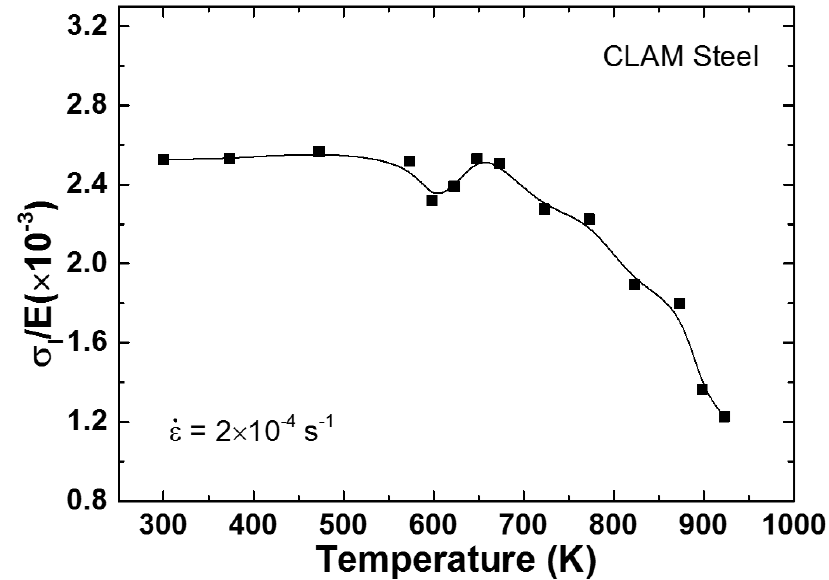
Figure 6. Variation of normalized initial stress ( σ I / E) with temperature at strain rate of 2 × 10 − 4 s − 1 in present China low activation martensitic (CLAM) steel.